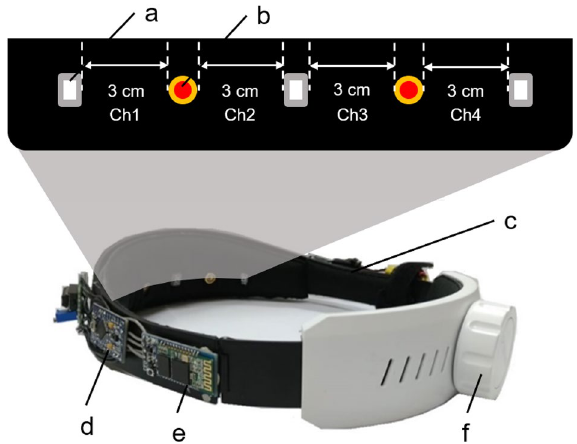
Figure 7. The wearable functional near-infrared spectroscopy system. ( a ) OPT101 ( b ) LED ( c ) Power source ( d ) MCU ( e ) Bluetooth module ( f ) Regulator knob.